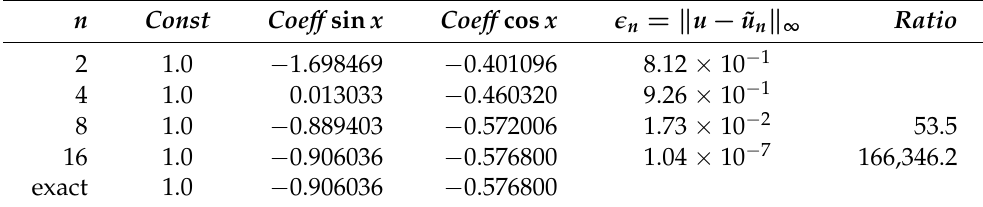
Table 1. IE (42). DKM: Taylor